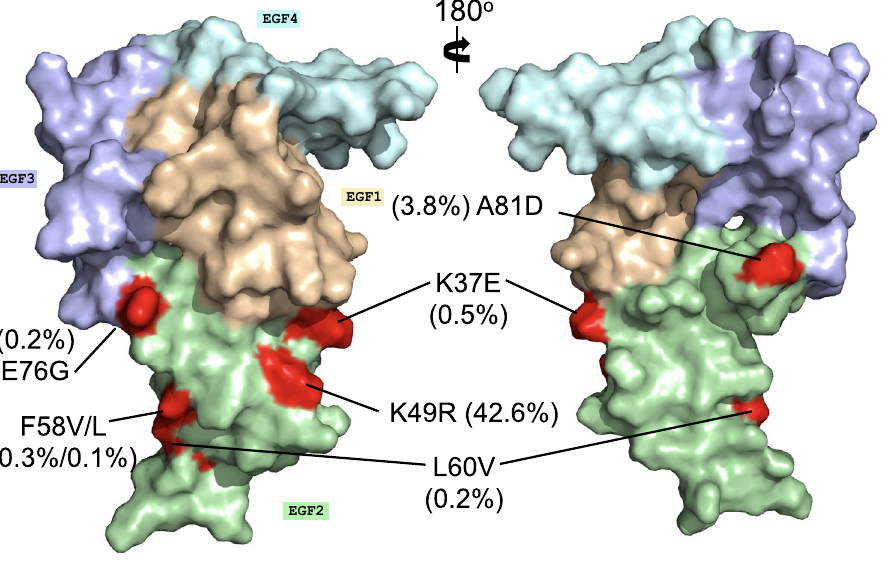
Figure 3. Polymorphism analysis of Pfs28. Surface representation of Pfs28 with EGF 1–4 colored wheat, pale green, light purple, and pale cyan. Polymorphic residues are colored in red and labelled with polymorphic frequencies according to database of 3,488 samples from MalariaGen 32 . Only polymorphisms with frequencies greater than 0.1% are